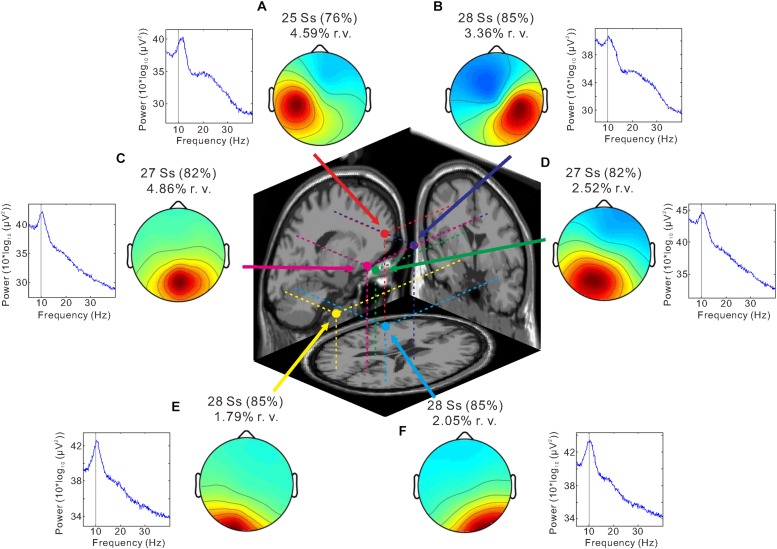
Independent component analysis (ICA) clustering. Scalp topography maps and estimated dipole centroid locations of the left sensorimotor cluster (A, red), right sensorimotor cluster (B, blue), parietal cluster (C, magenta), posterior cingulate cluster (D, green), left occipital cluster (E, yellow), and right occipital cluster (F, light blue) within a 3-shell boundary element model (BEM) of the Montreal Neurological Institute (MNI) standard brain. Graphs next to scalp maps display power spectra. Note that a peak is present at ∼10 Hz (thin vertical line) in all clusters. The number of subjects (Ss) contributing to each cluster and the mean residual variance (r. v.) are displayed above each scalp map.